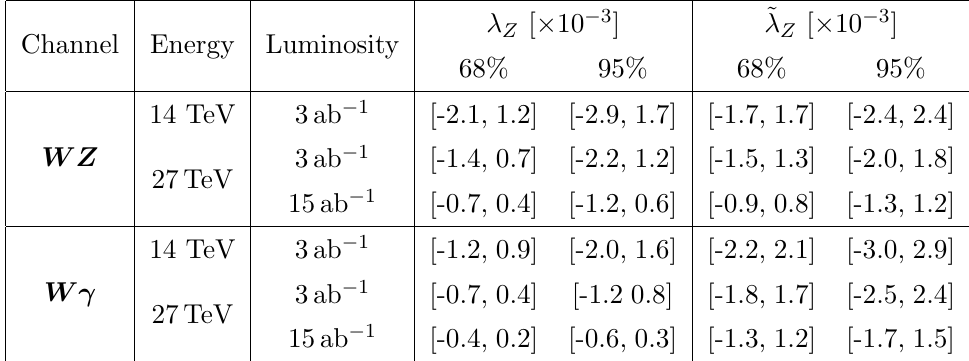
< 1 : 5 TeV are WZ;W(cid:13)